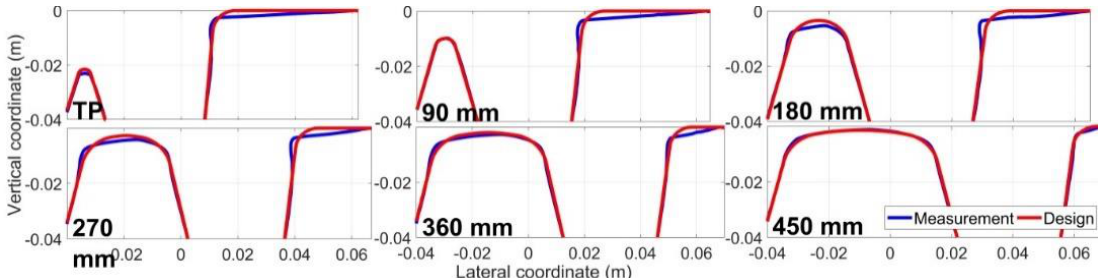
Figure 24. Measured crossing profiles in critical sections compared with the designed profiles.